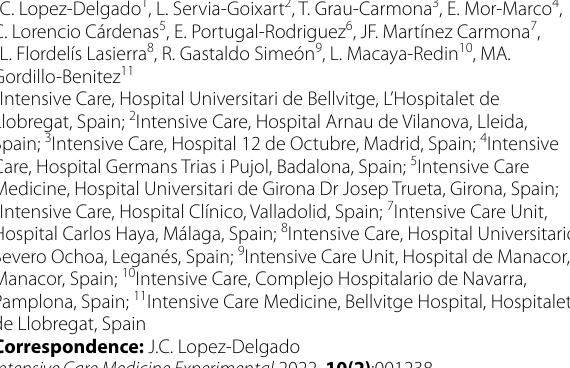
Table 1: Association between ICU mortality and nutritional assessment